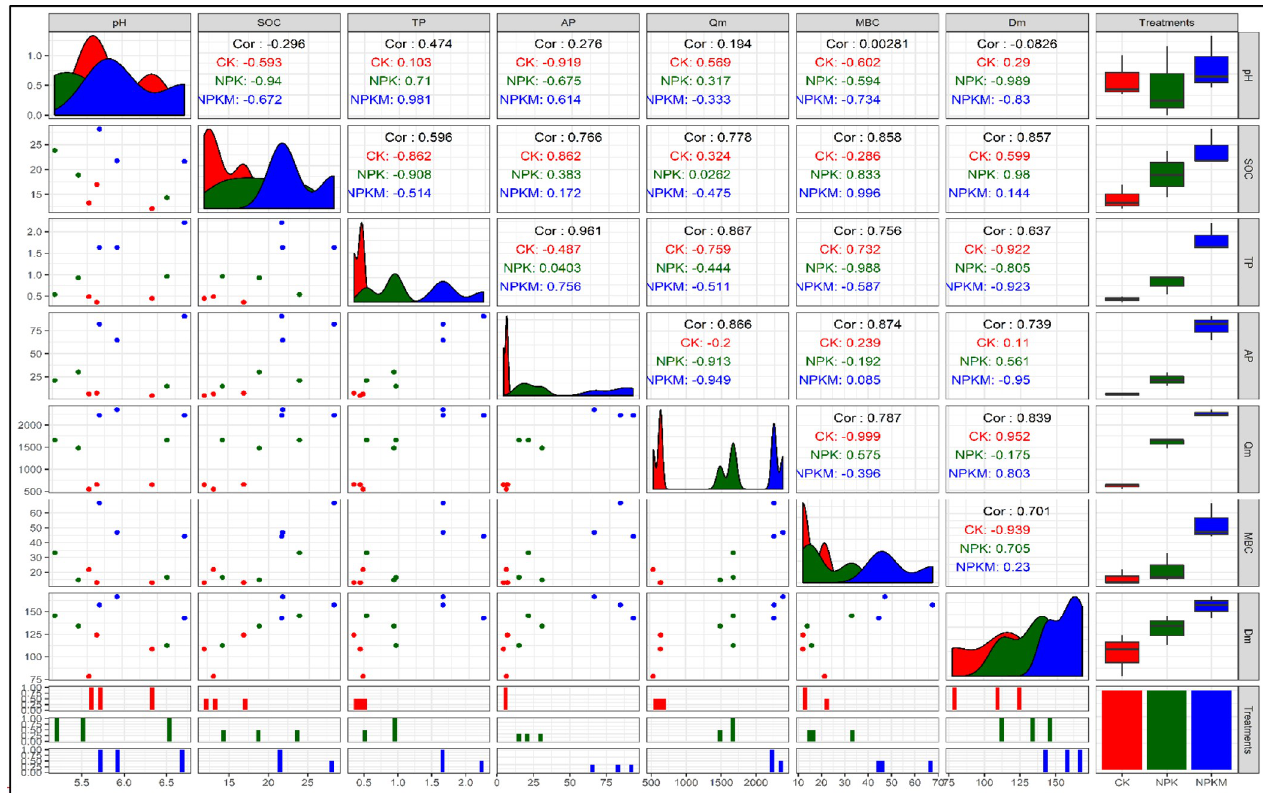
Fig 3. Correlation analysis among soil properties, Q m , and D m . The upper diagonal represents the correlation coefficient (the overall value is shown in black; the treatments are differentiated by color); the lower diagonal plots show the distribution of data along the axis; the box plots show the overall difference between the